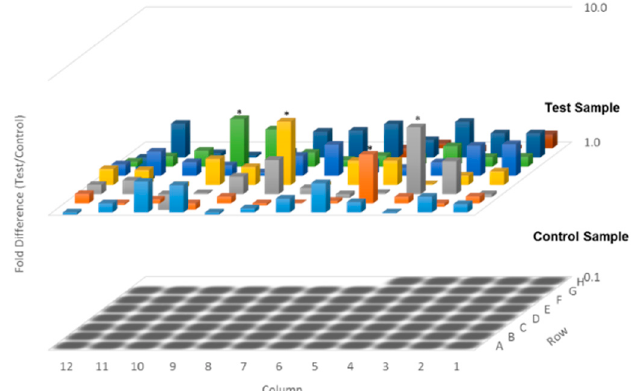
Figure 5. Evaluation of senescent status. HCT-116 cells were treated with DMSO (0.5%), FA (0.5–1.5 μ g/mL), or 5-fluorouracil (5-FU) (0.25 μ g/mL) for 48 h prior to staining. The cells showing SA- β -gal activity were stained cyan upon the addition of the substrate X-gal. Shown here are representative images from at least three independent batches of staining (scale bar = 50 μ m).